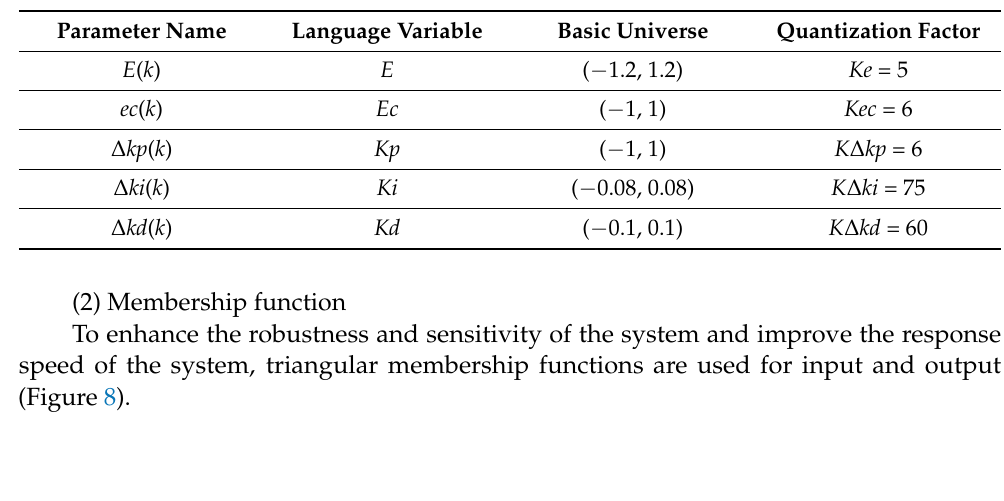
Table 1. Specific parameter settings of the fuzzy PID